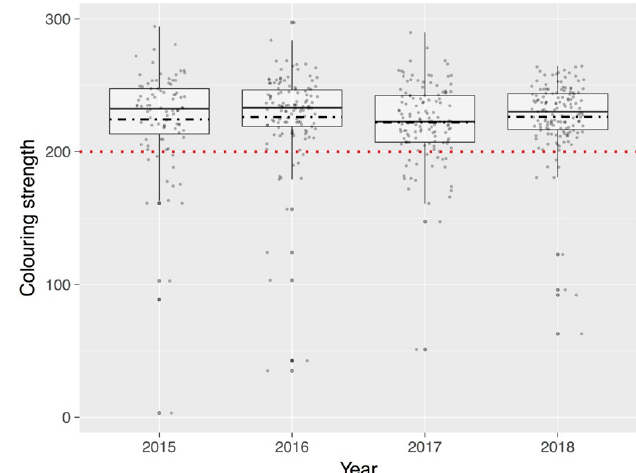
Fig. 4: Boxplots of flavour strength (picrocrocin) of the saffron samples collected/analyzed during the four years (2015-2018). Red broken lines show the minimum limit of the first quality category (ISO 3632 1,2:2010-2011). For each boxplot, mean (black broken line) and median (black line) were highlighted.